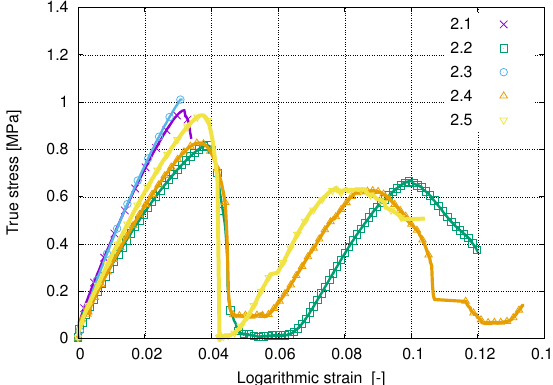
Figure 4. Stress-strain curves of specimens in group 0.